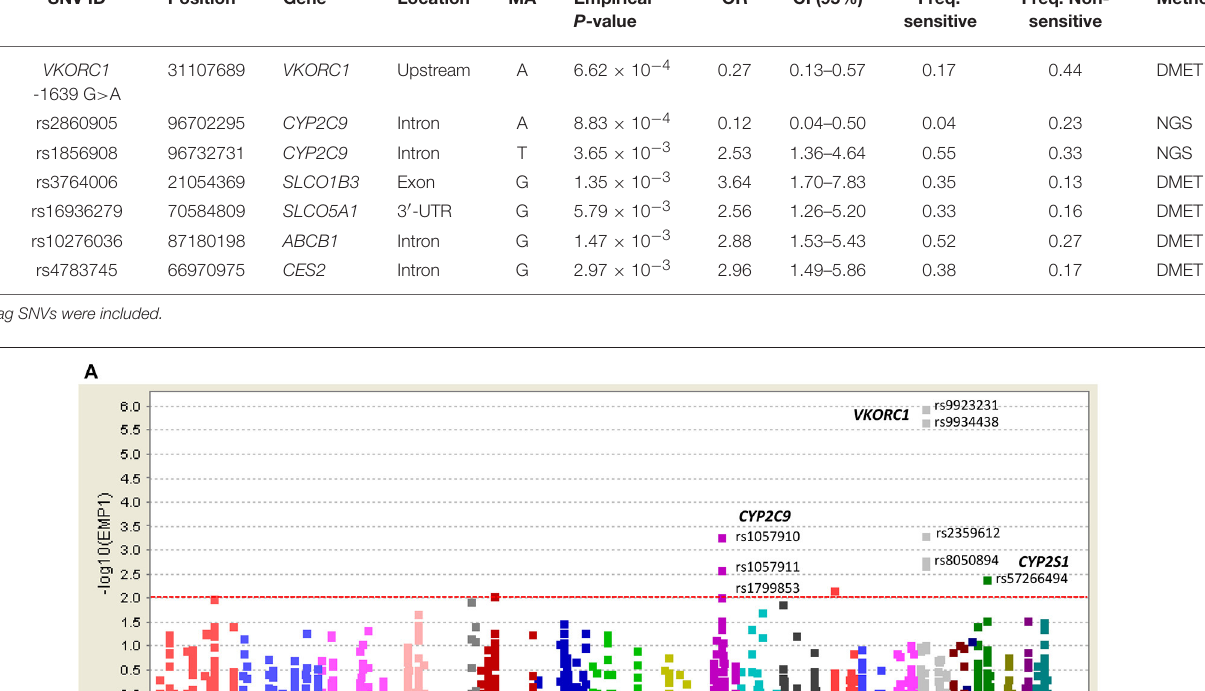
(warfarin users and participants of the 1000 Genomes Project) and contained CYP2C9 ∗ 8 (rs7900194). CYP2C9 ∗ 8 was found